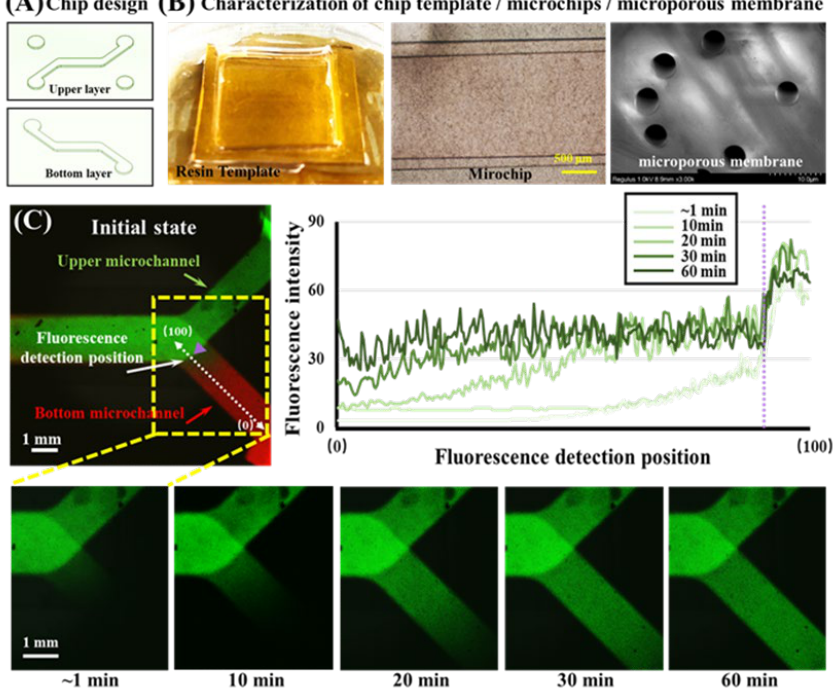
Figure 2. ( A ) Design of the 3D printed chip template. ( B ) Microscopy or SEM images of chip templates, microchips, and microporous membranes. ( C ) Fluorescence images and plots of fluorescence intensity profiles for the characterization of small molecule diffusion in a microchip. Green, RH-123 aqueous solution. Red, RH-B aqueous solution. Scale bar = 1 mm.